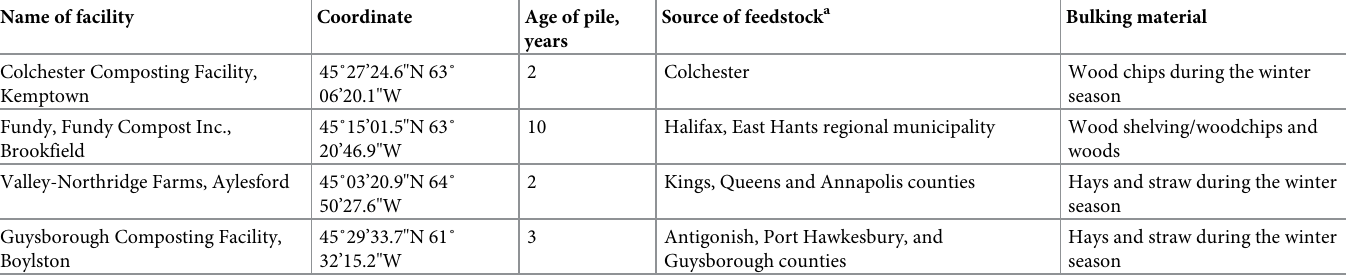
Table 1. Description of compost facilities, age of compost and source of